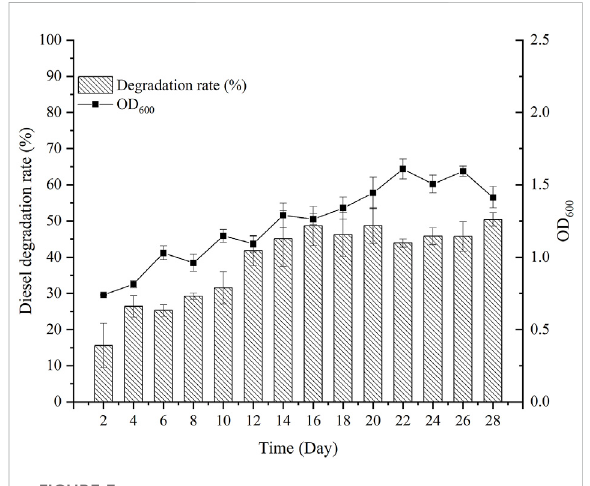
FIGURE 3 GrowthcurveofstrainKJ-1anditsremovaleffectondieselin MSM